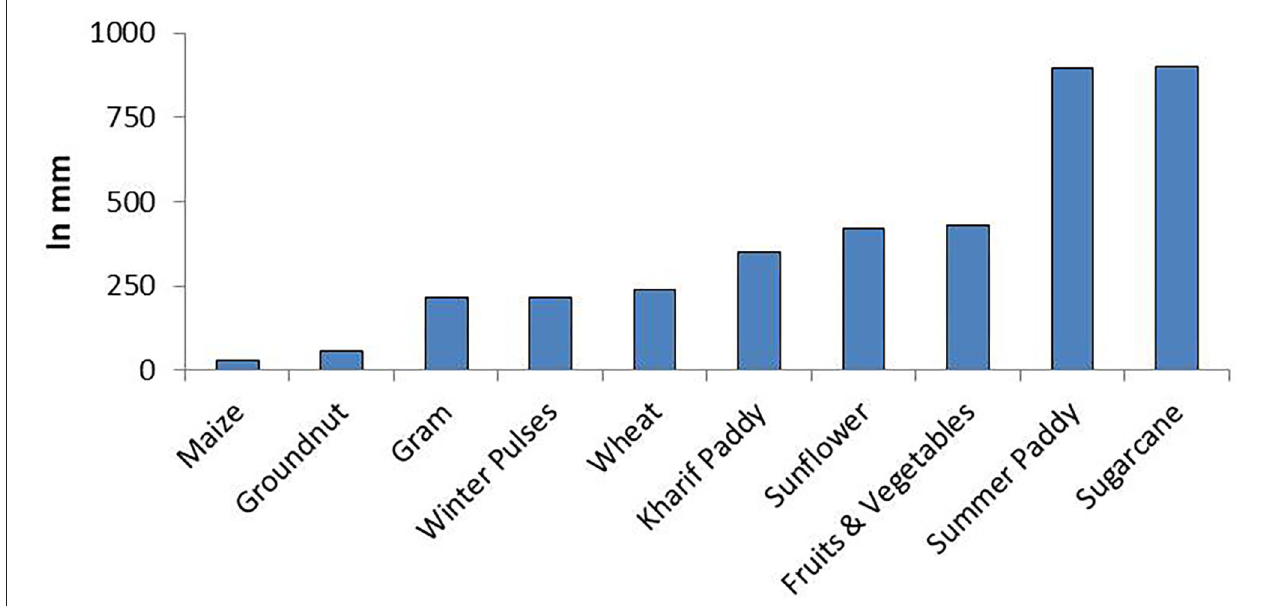
FIGURE 6 | Average irrigation water requirement for different crops in the study area. Source: Estimates based on FAO